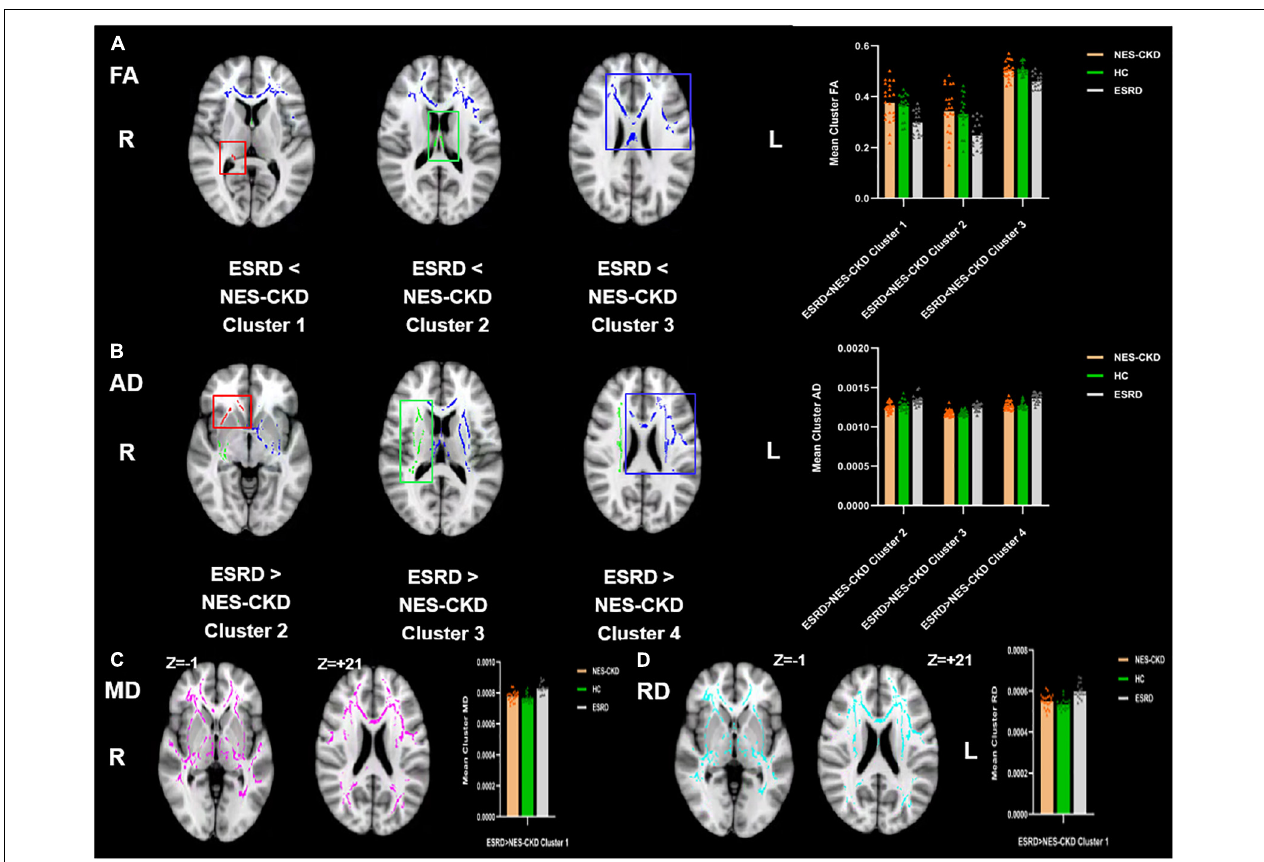
FIGURE 1 | Voxel clusters in which patients with ESRD exhibited decreased FA or increased AD, MD, or RD than NES-CKD. (A) Three independent clusters (red for Cluster 1; green for Cluster 2; blue for Cluster 3) with lower FA values in ESRD vs. NES-CKD. (B) Three independent clusters (red for Cluster 2; green for Cluster 3; blue for Cluster 4) with higher AD values in ESRD vs. NES-CKD. (C) One independent cluster (pink) with higher MD values in ESRD vs. NES-CKD. (D) One independent cluster (light blue) with higher RD values in ESRD vs. NES-CKD. The bar plots represent the corresponding mean diffusion metrics for each group. The triangle symbols indicate the data points of each participant in each group. ESRD, end-stage renal disease; NES-CKD, non-end-stage chronic kidney disease; HC, healthy control; FA, fractional anisotropy; MD, mean diffusivity; AD, axial diffusivity; RD, radial